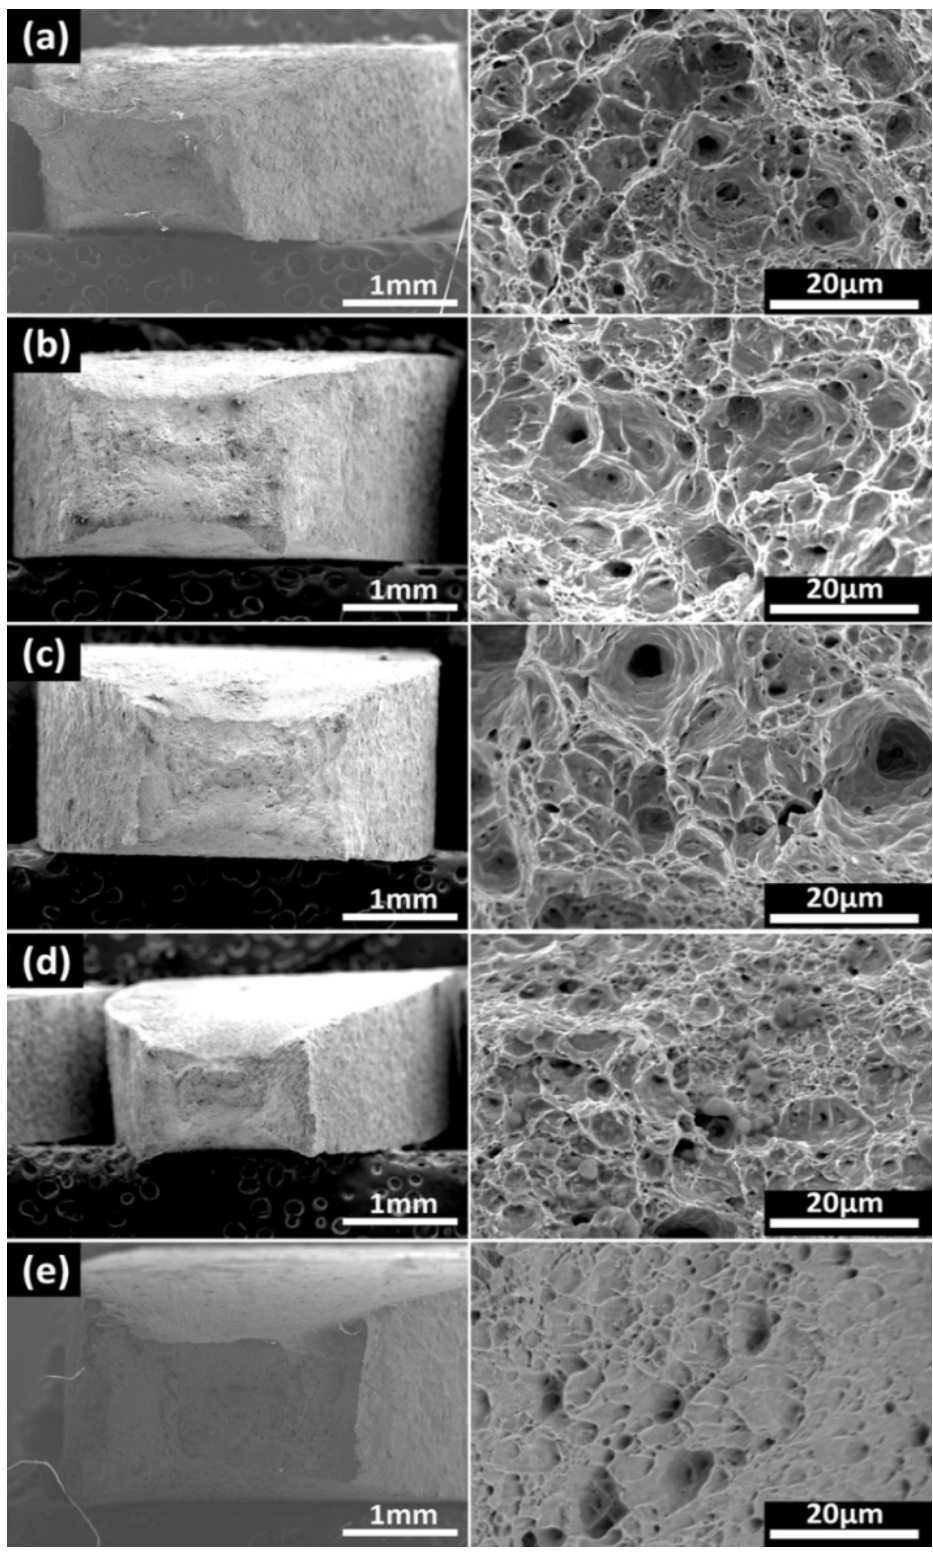
Figure 9. Fracture morphologies for the X80 steel under different CP potentials at 30 °C: ( a ) OCP,